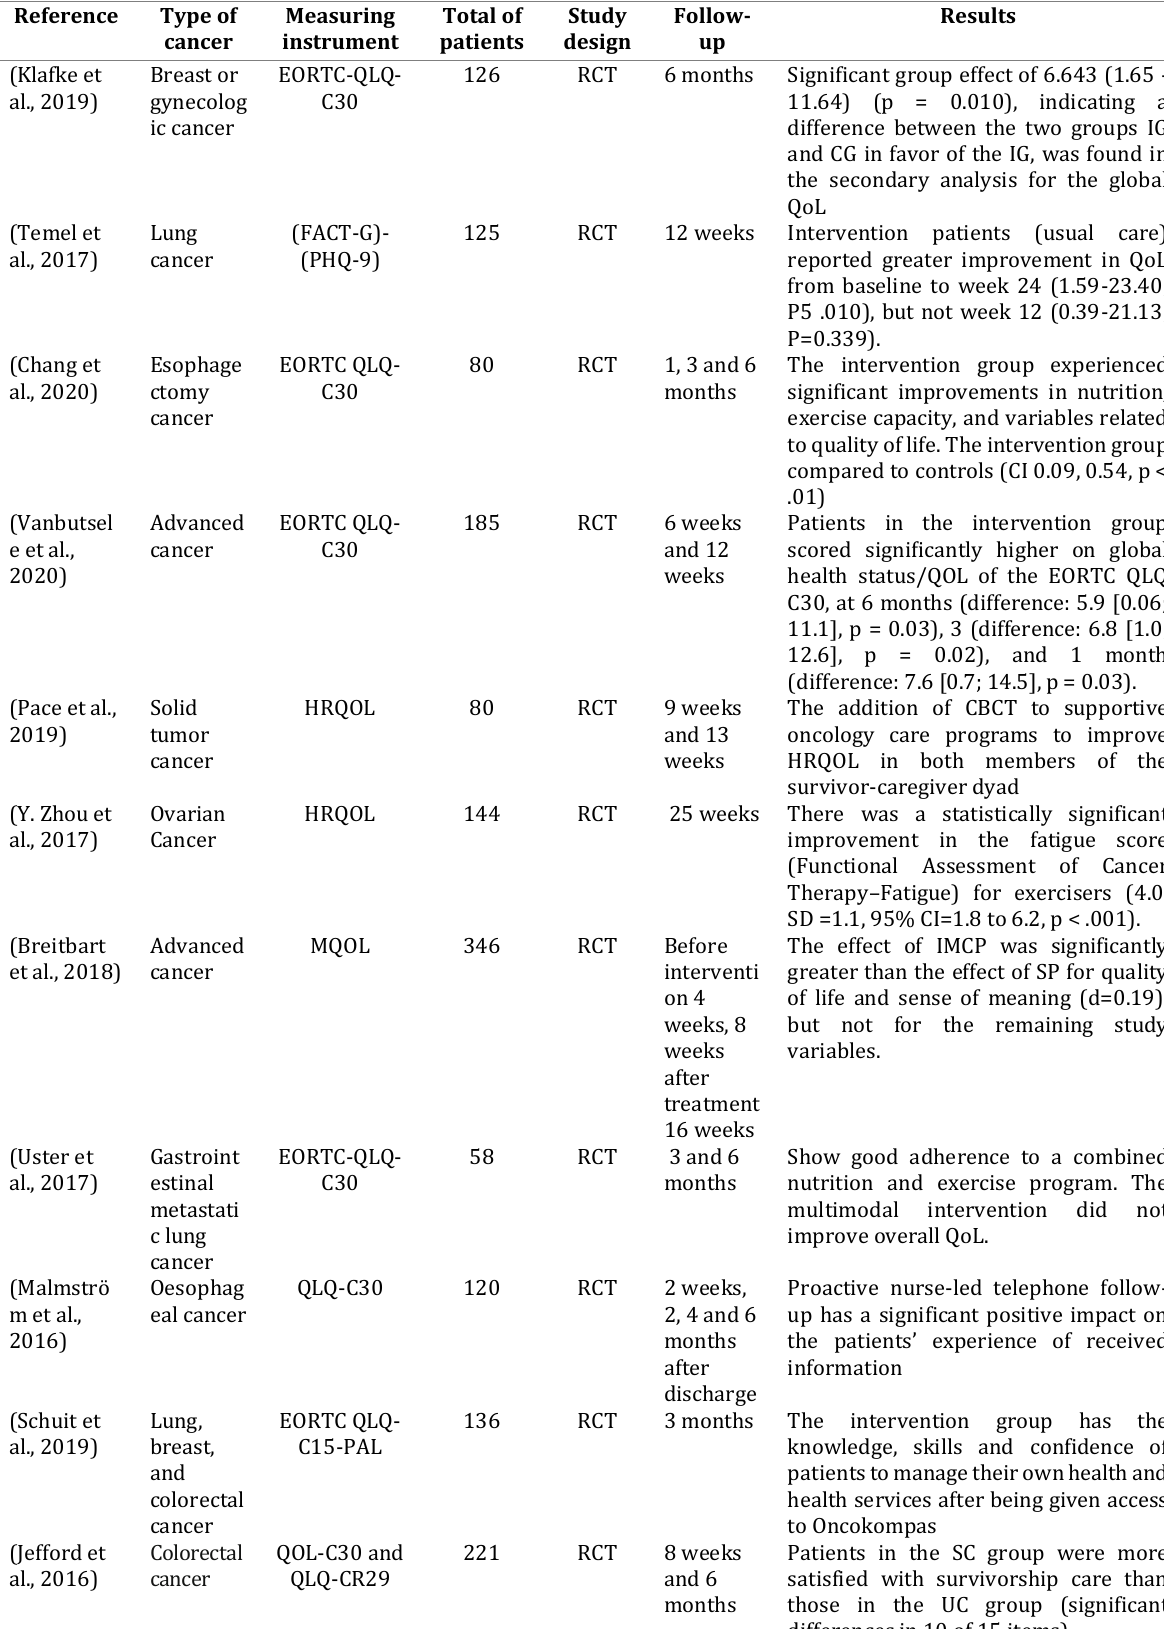
Table I. Summary of characteristics of included studies